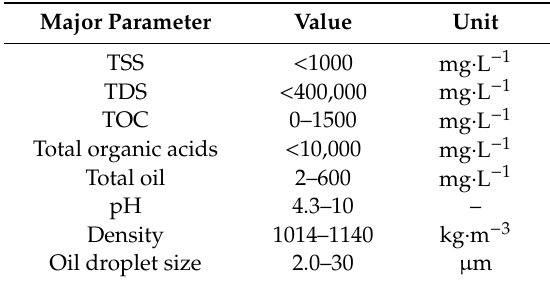
Table 1. Main contaminants found in produced water and their concentrations. TSS = total suspended solids; TDS = total dissolved solids; TOC = total organic carbon.